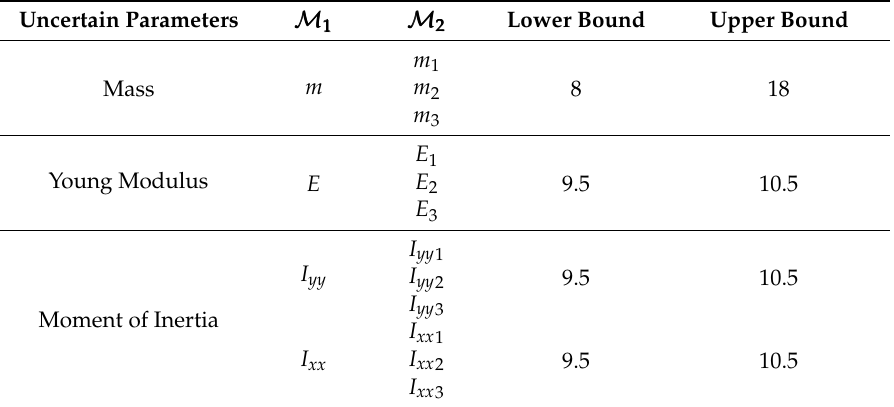
Table 4. Prior distribution bounds for the components in the structural model parameter vector θ